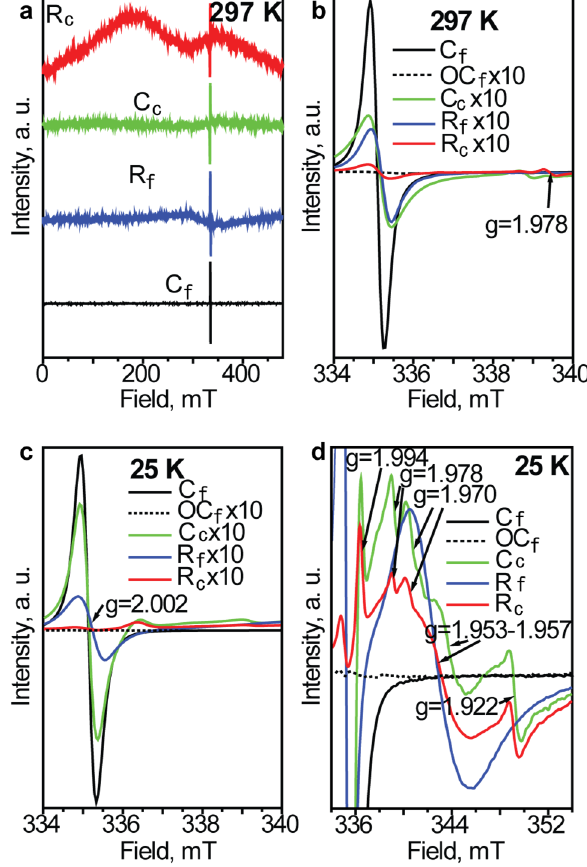
Figure 5. ( a ) Broadband and ( b – d ) short range EPR spectra of C-doped reduced ( C f and C c ) and undoped reduced ( R f and R c ) STO nanopowders taken at room temperature ( a , b ) and at 25 K ( c , d ). The spectrum of fine oxidized carbon-doped powder ( OC f ) is given for comparison. For all the fig- ures, sample mass was fixed as 20 mg, with the exception of Figure 5a.